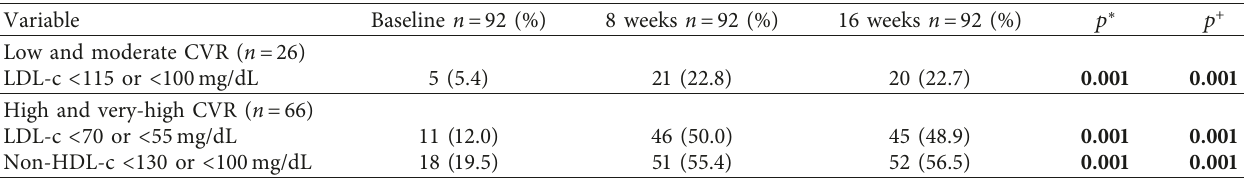
Table 4: Therapeutic goals according to cardiovascular